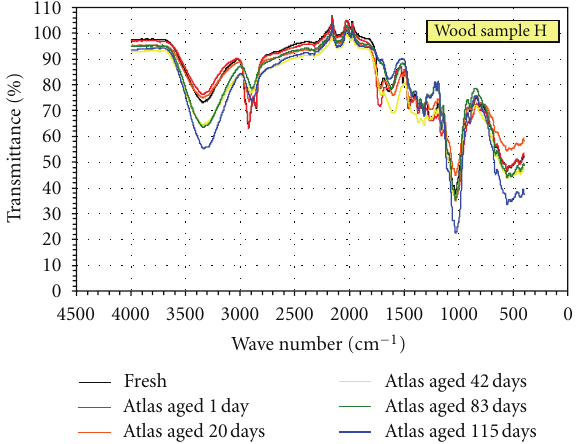
Figure 3: Transmittance versus wave number between 4000– 400cm − 1 for wood sample A during accelerated ageing in an Atlas Solar Simulator.